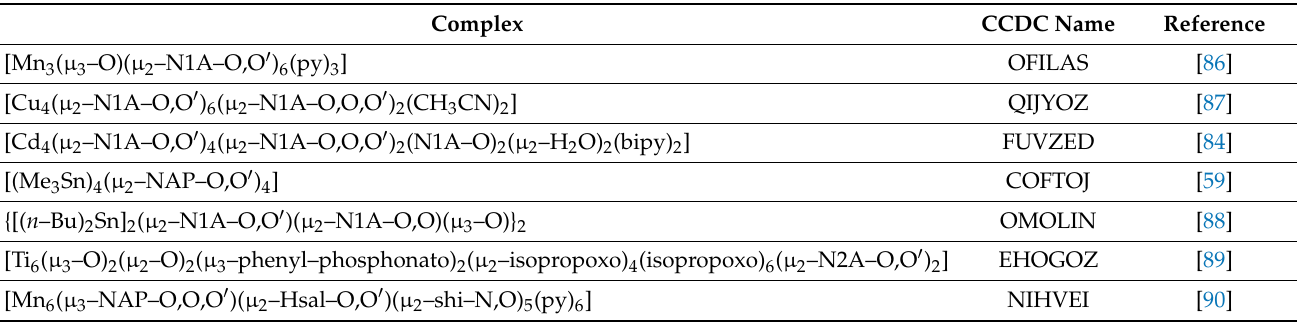
Table 3. Polynuclear complexes of 1–naphthylacetato, 2–naphthylacetato and naproxen ligands. Coordination mode of the ligands and CCDC name of the